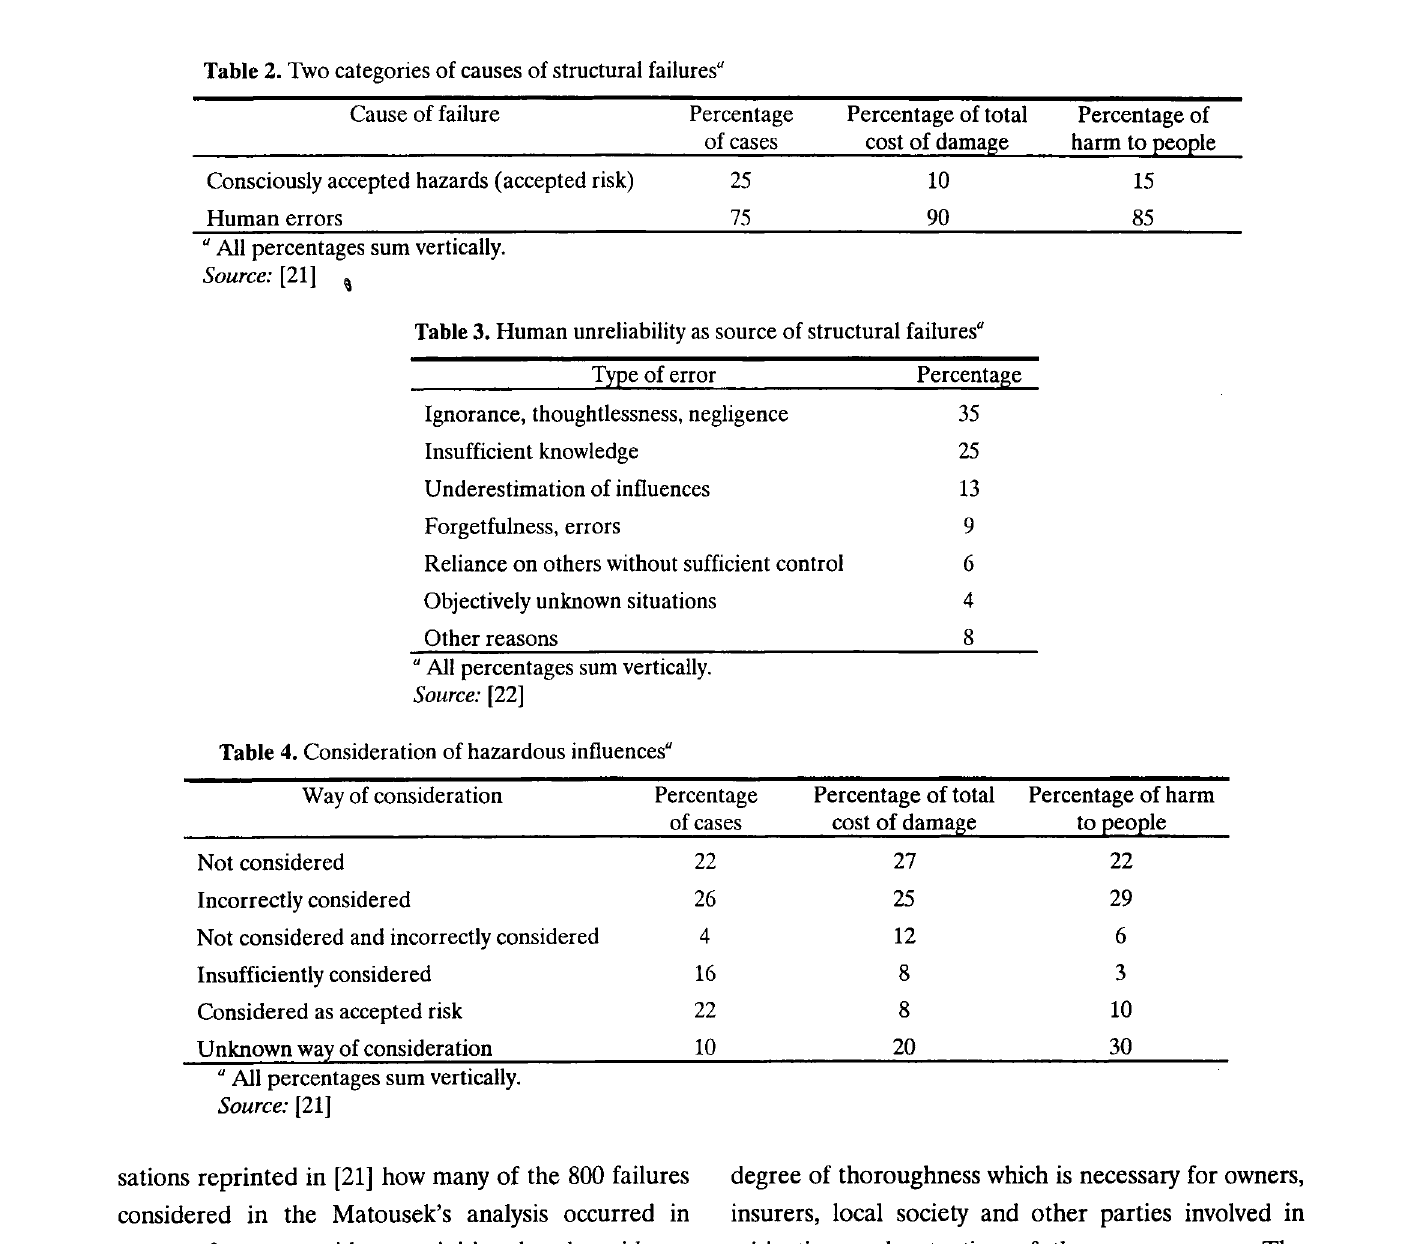
Table 2. Two categories of causes of structural failures" Cause of failure Percentage Percentage of total Percentage of of cases cost of damage harm to people